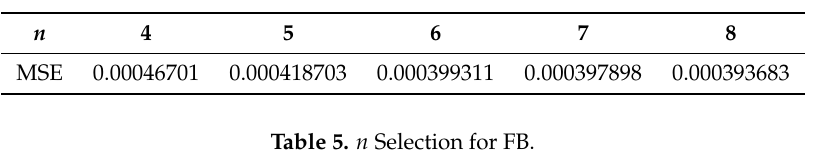
Table 4. n Selection for EBAY.